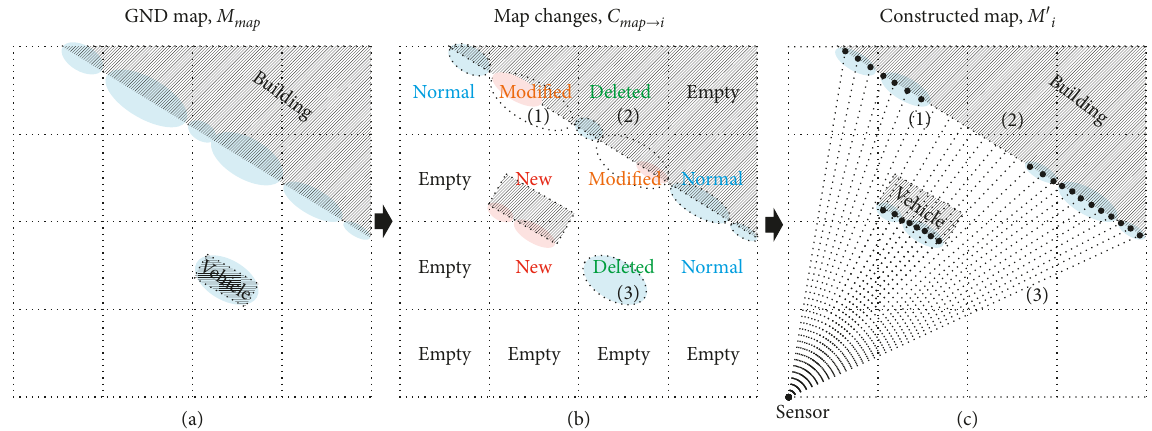
Map changes, C map → i